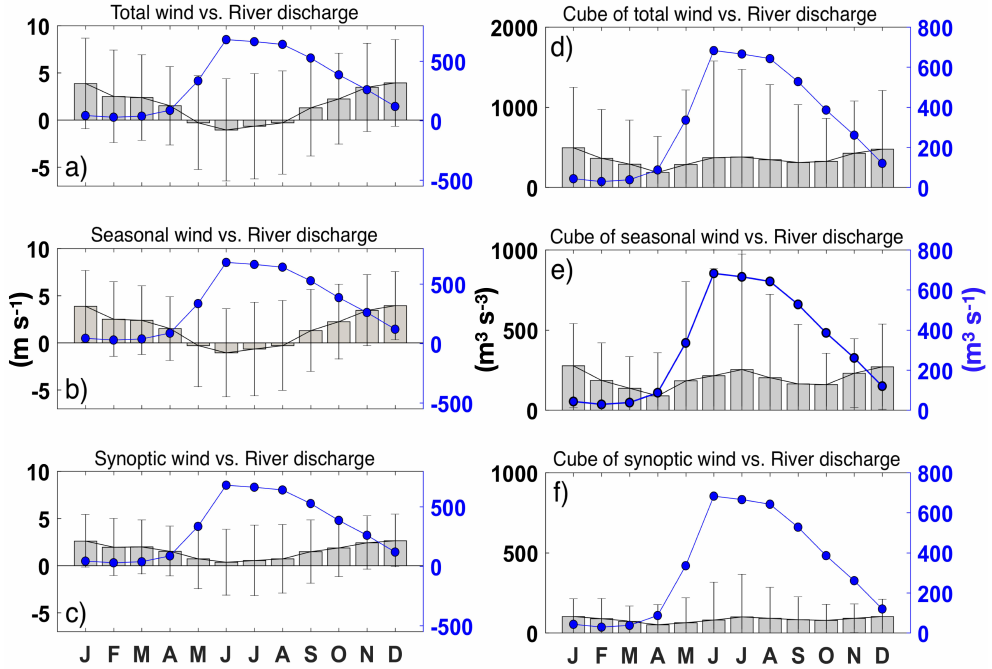
Figure 3. Monthly climatological averages (1999–2009) of ( a ) Alongshore total wind, ( b ) Alongshore seasonal wind (Period > 16 days), ( c ) Alongshore synoptic wind (Periods between 2–16 days), ( d ) Cube of total wind speed magnitude, ( e ) Cube of seasonal wind-speed magnitude, ( f ) Cube of synoptic wind speed magnitude. The monthly discharge of the Itata River is plotted in all panels (blue line). Historic wind data was obtained from the Carriel Sur station (see Figure 1 for its location). The cube of the wind speed represents the mechanical wind energy available to generate